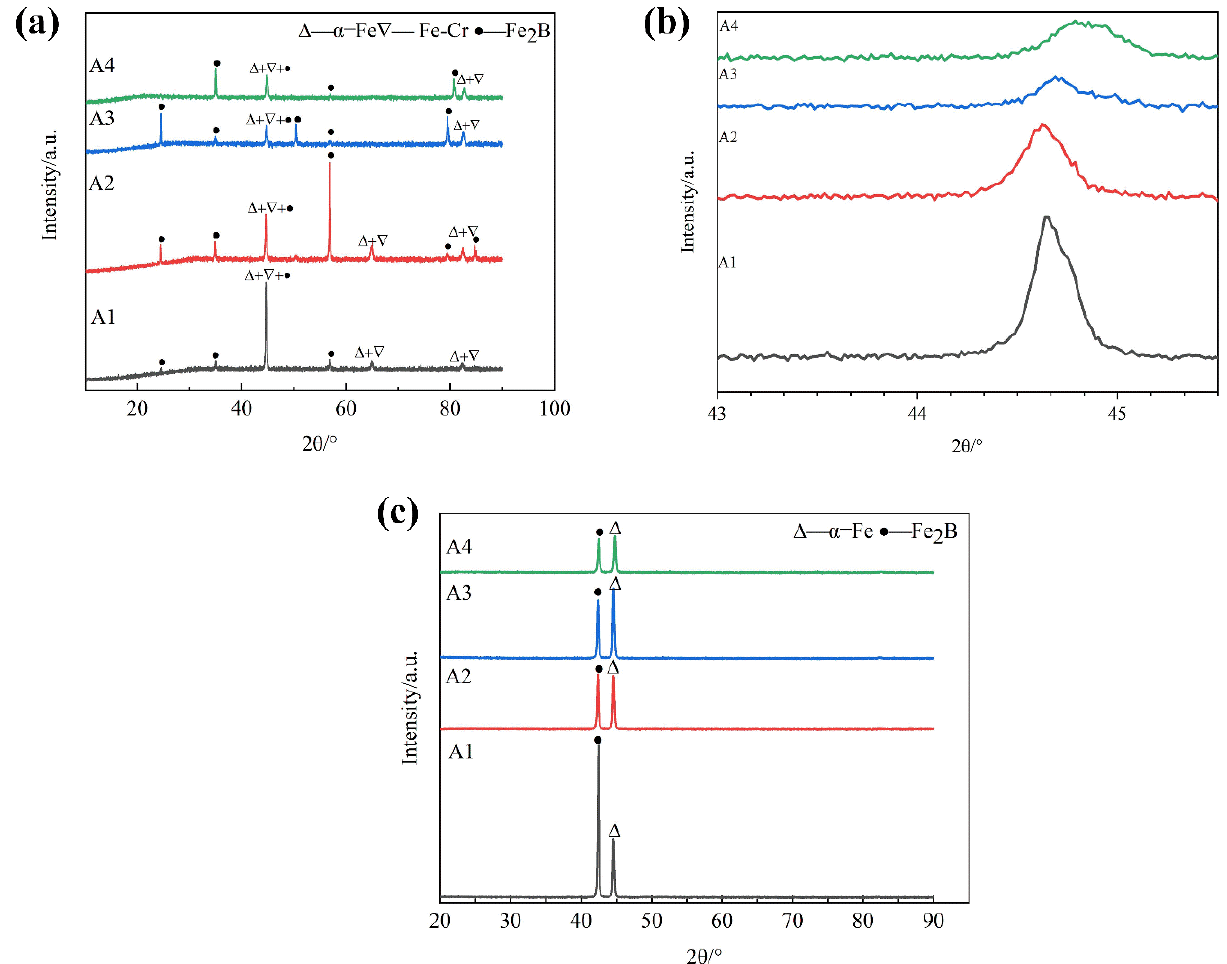
Figure 4. XRD patterns of the as-cast DS Fe-B alloy: ( a ) longitudinal section, ( b ) local peaks of Fe (110) in longitudinal section, ( c ) transverse section.